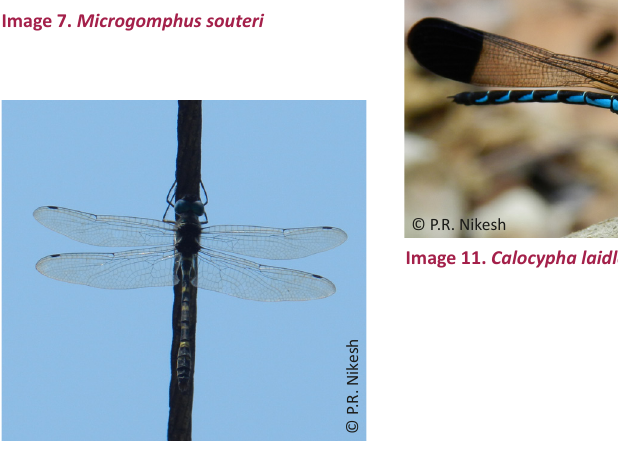
Image 10. Macromia annaimalaiensis